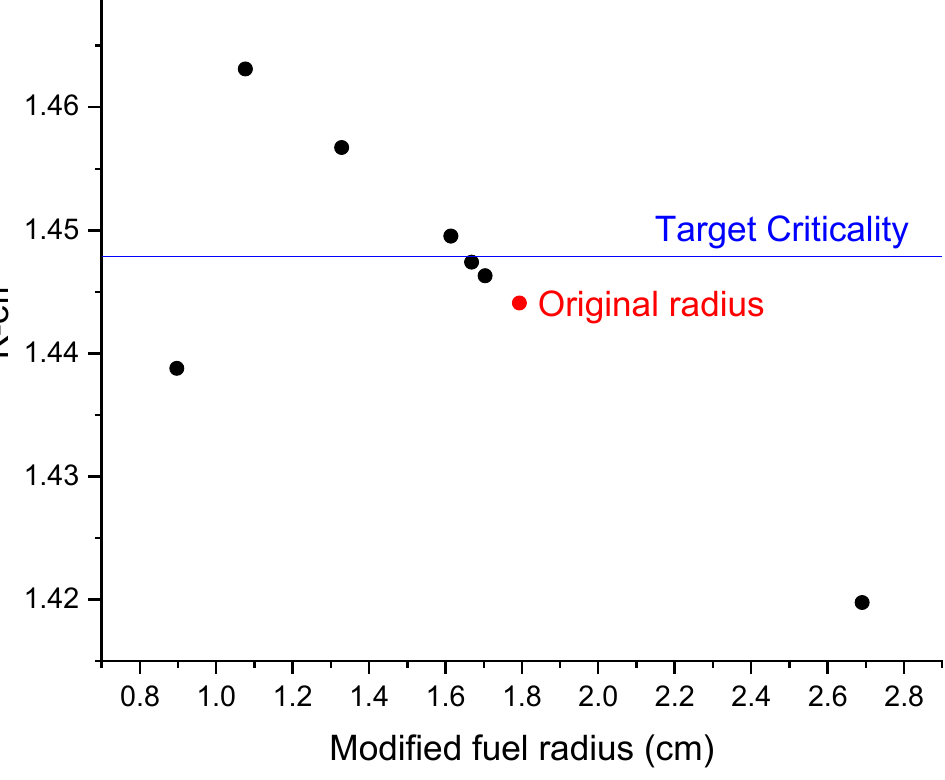
Figure 4. Effect of modification of the fuel radius with compensating density modification across several different modified fuel radii. It can be seen that the behaviour is predictable for most degrees of modification with higher criticality being calculated for denser fuel, due to the reduction in the e ff ect of self-shielding.